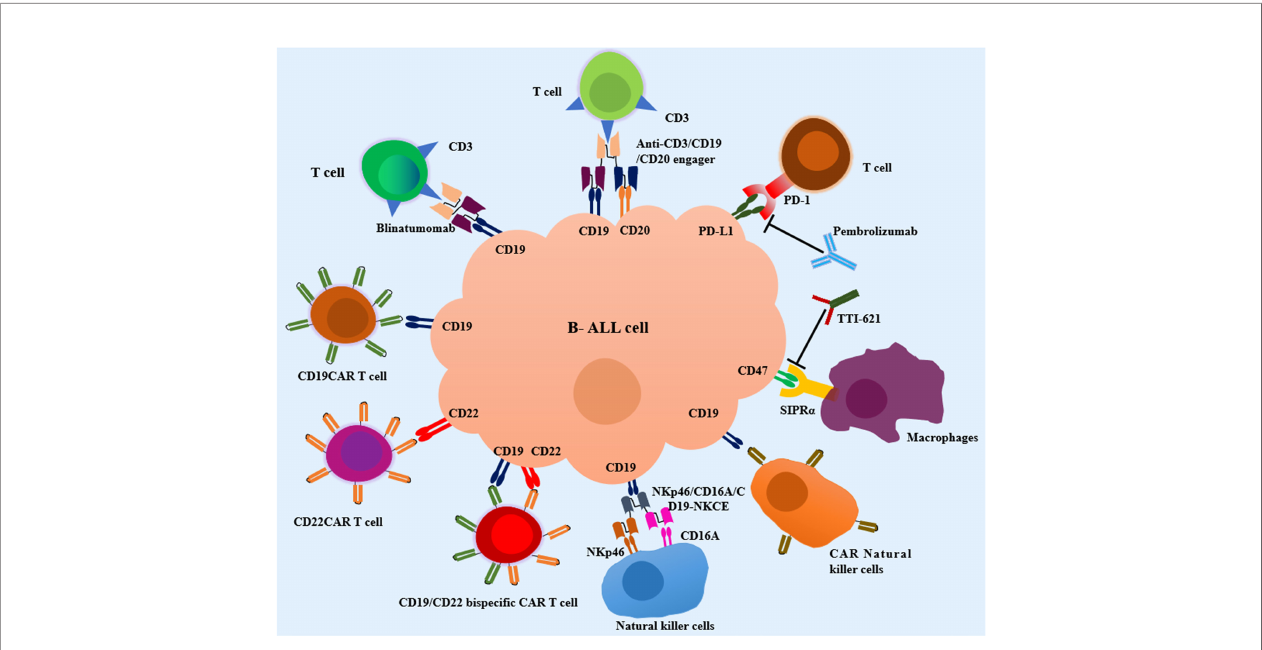
FIGURE 1 | Current immunotherapeutic strategies in pediatric Acute Lymphoblastic Leukemia (ALL). T-cell engagers, CAR T cell therapy, macrophages-based immunotherapy, NK cell-based immunotherapy and other emerging immunotherapies are in development for pediatric B-cell ALL. SIRP a , signal regulatory protein alpha; NKp46/CD16A/CD19-NKCE, a NK cell engager with CD16A on the surface of NKs binding NKp46 and CD19 on the surface of B-cell ALL